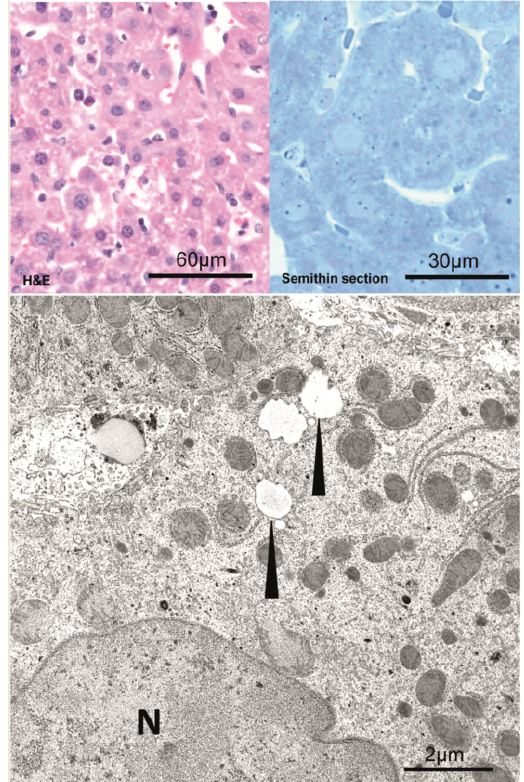
Figure 5. After 60 min, almost all vesicles (arrowheads and hepatocellular alterations vanished. N—nucleus. Scale bars are indicated.